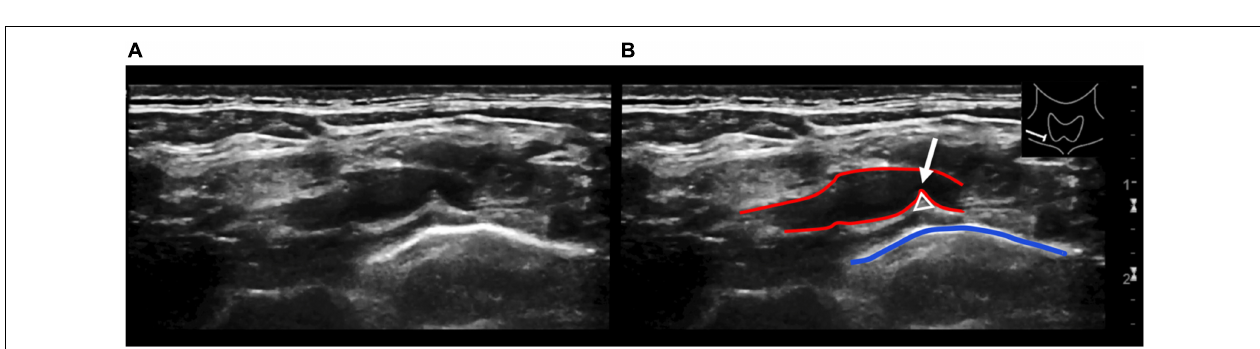
FIGURE 3 | Axial ultrasound image of the supraclavicular neck region on the left showing the subclavian artery and anterior and posterior divisions of the brachial plexus (A) . Adjacent is the tip of the stump rib with partially depicted accessory ligament extending caudally from the tip of the stump. Illustration of the same ultrasound image (B) . Subclavian artery (red circle), the anterior and posterior divisions (yellow circles) the stump rib (white line) and the accessory ligament (blue lines).